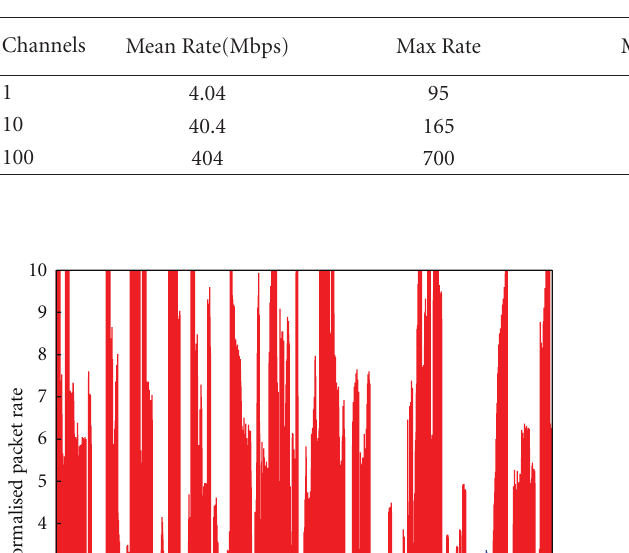
Table 1: Statistics on aggregated tra ffi c.